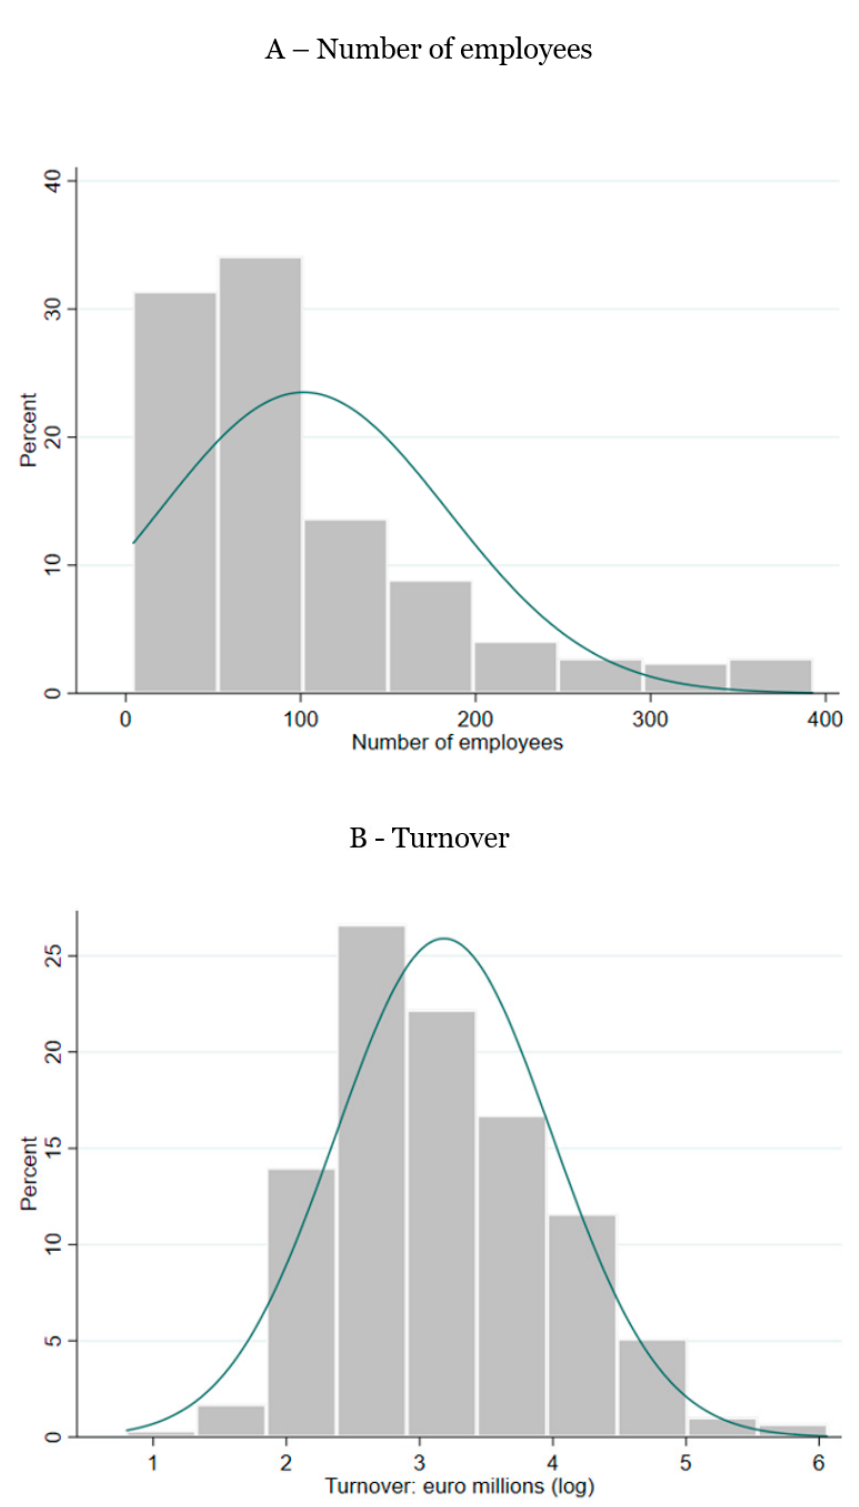
Figure A2. Size of Firms and Turnover in the Sample.